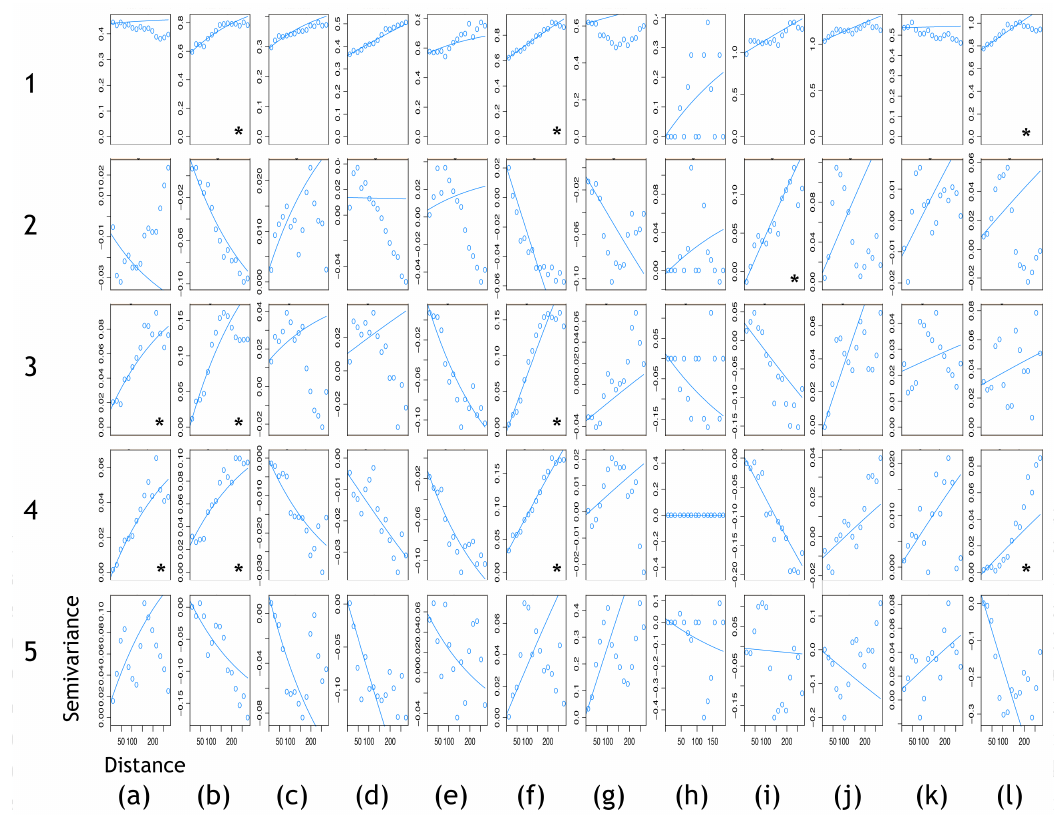
Figure 4. Cross-variography. ( a ) Ae. japonicus ; ( b ) Ae. vexans ; ( c ) An. punctipennis ; ( d ) An. quadrimaculatus ; ( e ) An. walkeri ; ( f ) Cx. pipiens/restuans ; ( g ) Cx. salinarius ; ( h ) Cx. tarsalis ; ( i )